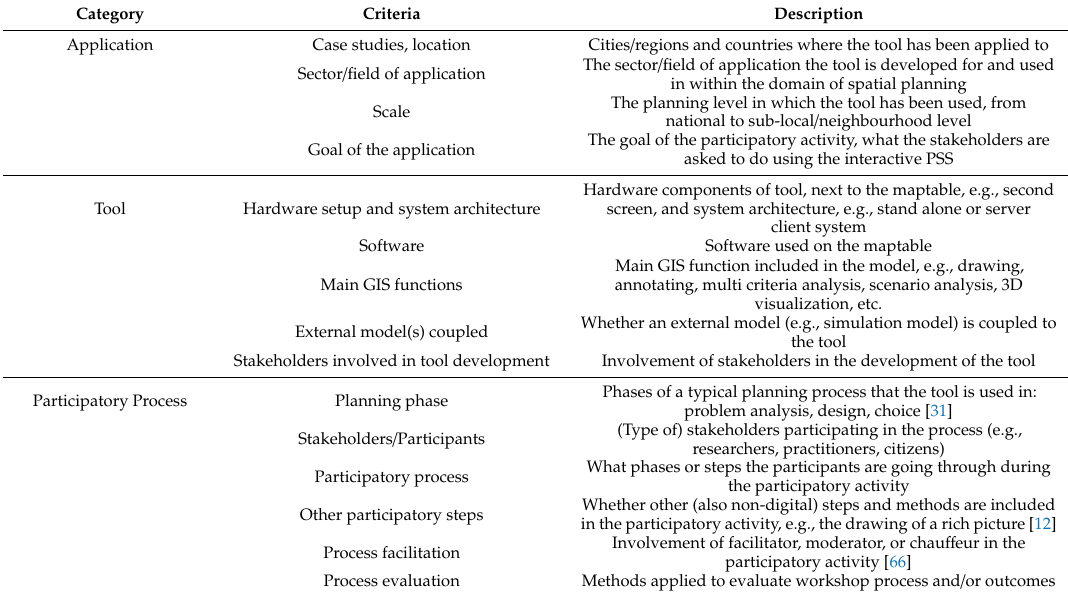
Table 3. Planning Support Systems (PSS) Review